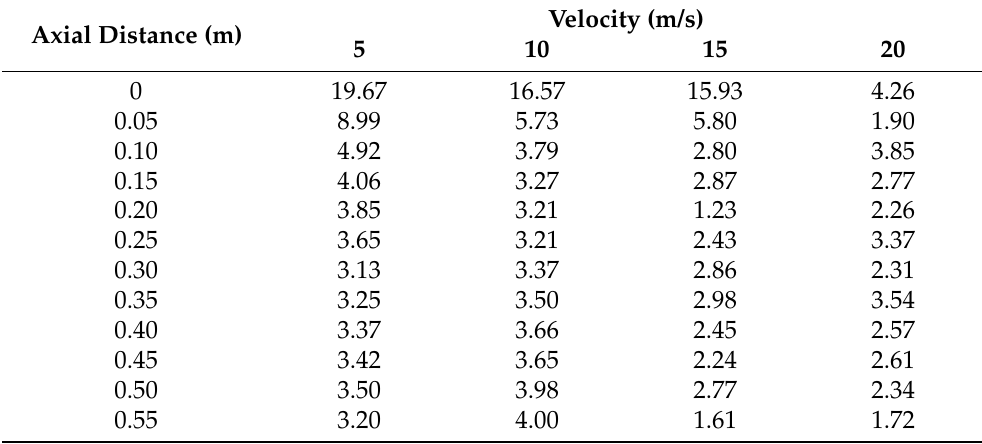
Table 3. The relative errors (%) between the experimental and simulation results under various